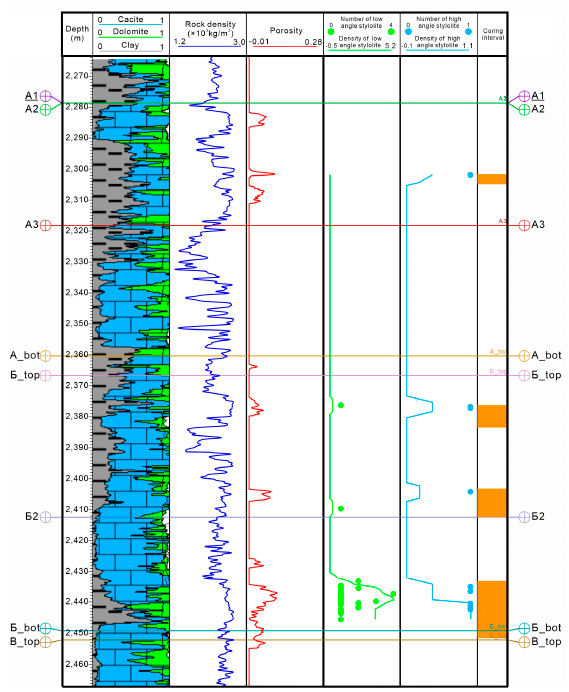
Energies 2023 , 16 , x FOR PEER REVIEW Figure 9. The intensity of stylolites at different depths of well N ‐ 52 in the NT oilfield. Figure 9. The intensity of stylolites at different depths of well N-52 in the NT oilfield.